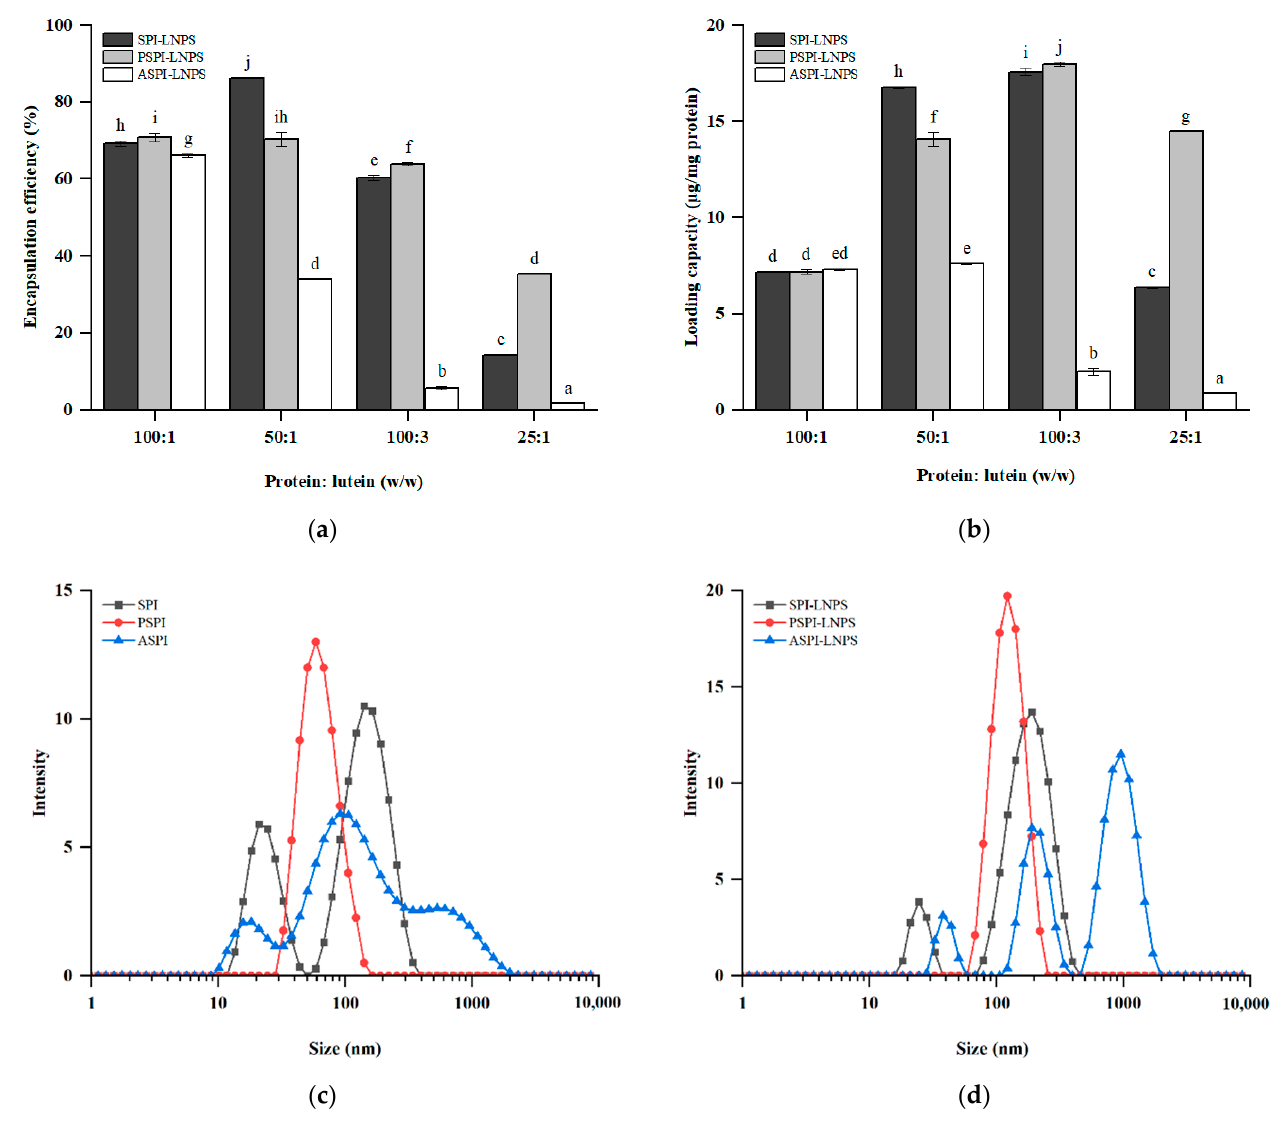
Figure 2. ( a ) Encapsulation efficiency (EE) of lutein in SPI-LNPS, PSPI-LNPS, and ASPI-LNPS; ( b ) loading capacity (LC) of lutein in SPI-LNPS, PSPI-LNPS, and ASPI-LNPS; ( c ) SPI, PSPI, and ASPI particle size distributions under protein concentration of 0.25 mg/mL; ( d ) SPI-LNPS, PSPI-LNPS, and ASPI-LNPS particle size distributions under protein concentration of 0.25 mg/mL with the mass ratio of 100:3 between protein and lutein. The standard deviation is represented by the bars. Columns denoted by different letters (a–j) indicate a statistically significant difference ( p < 0.05).